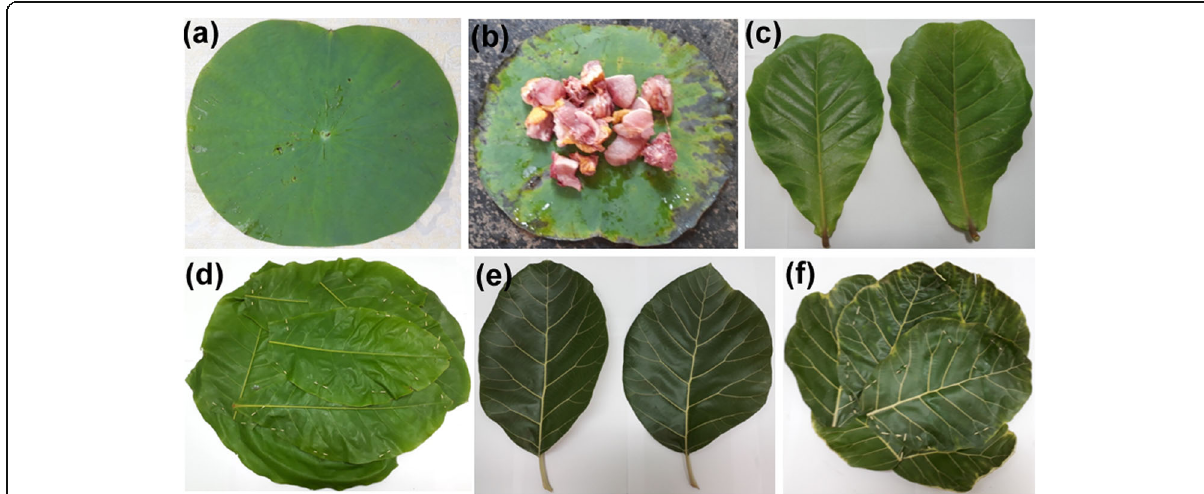
Fig. 4 a The leaf of lotus, N. nucifera , ( b ) the application of lotus leaf for packing meat, ( c ) the leaves of Indian badam , T. catappa , ( d ) the hand stitched dining plate made from the leaves of Indian badam , ( e ) the leaves of teku, T. grandis and ( f ) the hand stitched dining plate made from the leaves of